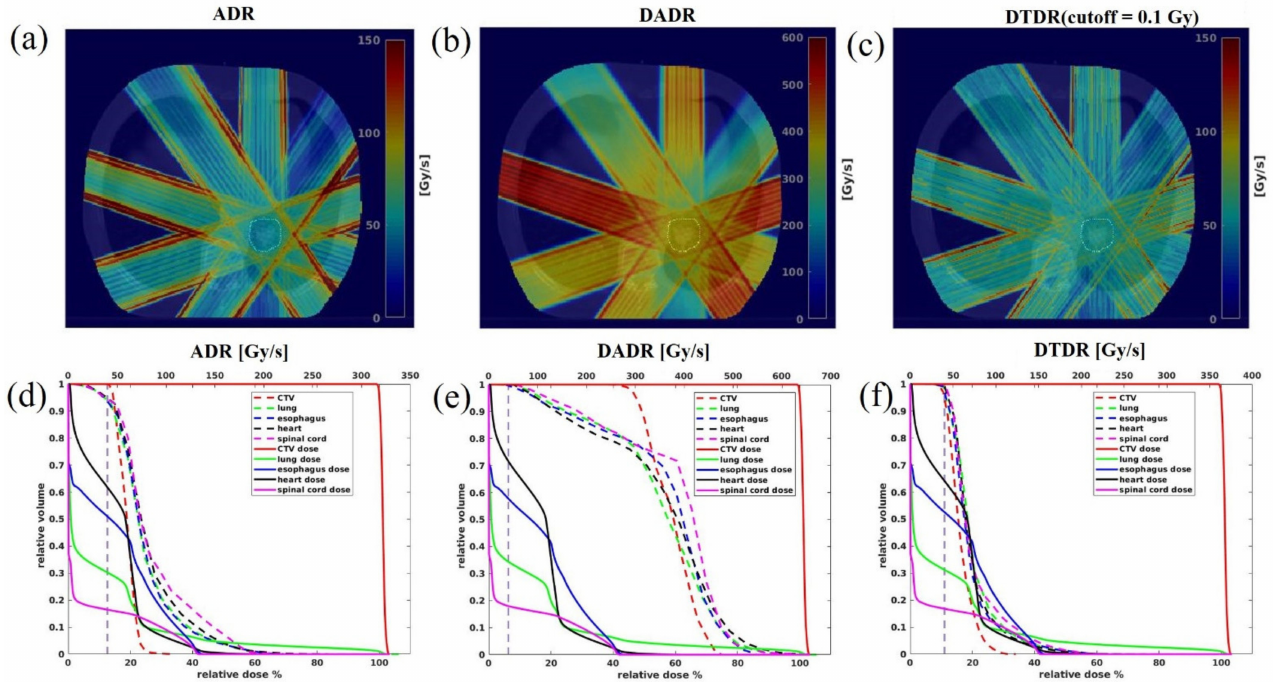
Figure 6. The dose rate comparison among all three methods for a typical patient using a minimum 400 MU/spot and 34 Gy × 1 fraction. ( a – c ) Show the dose rate distributions from each different field over patient anatomy, ( d – f ) are the DVHs and DRVHs, the solid lines are DVHs and the dashed lines are the DRVHs, and the 40 Gy/s dose rate is indicated by the vertical dashed